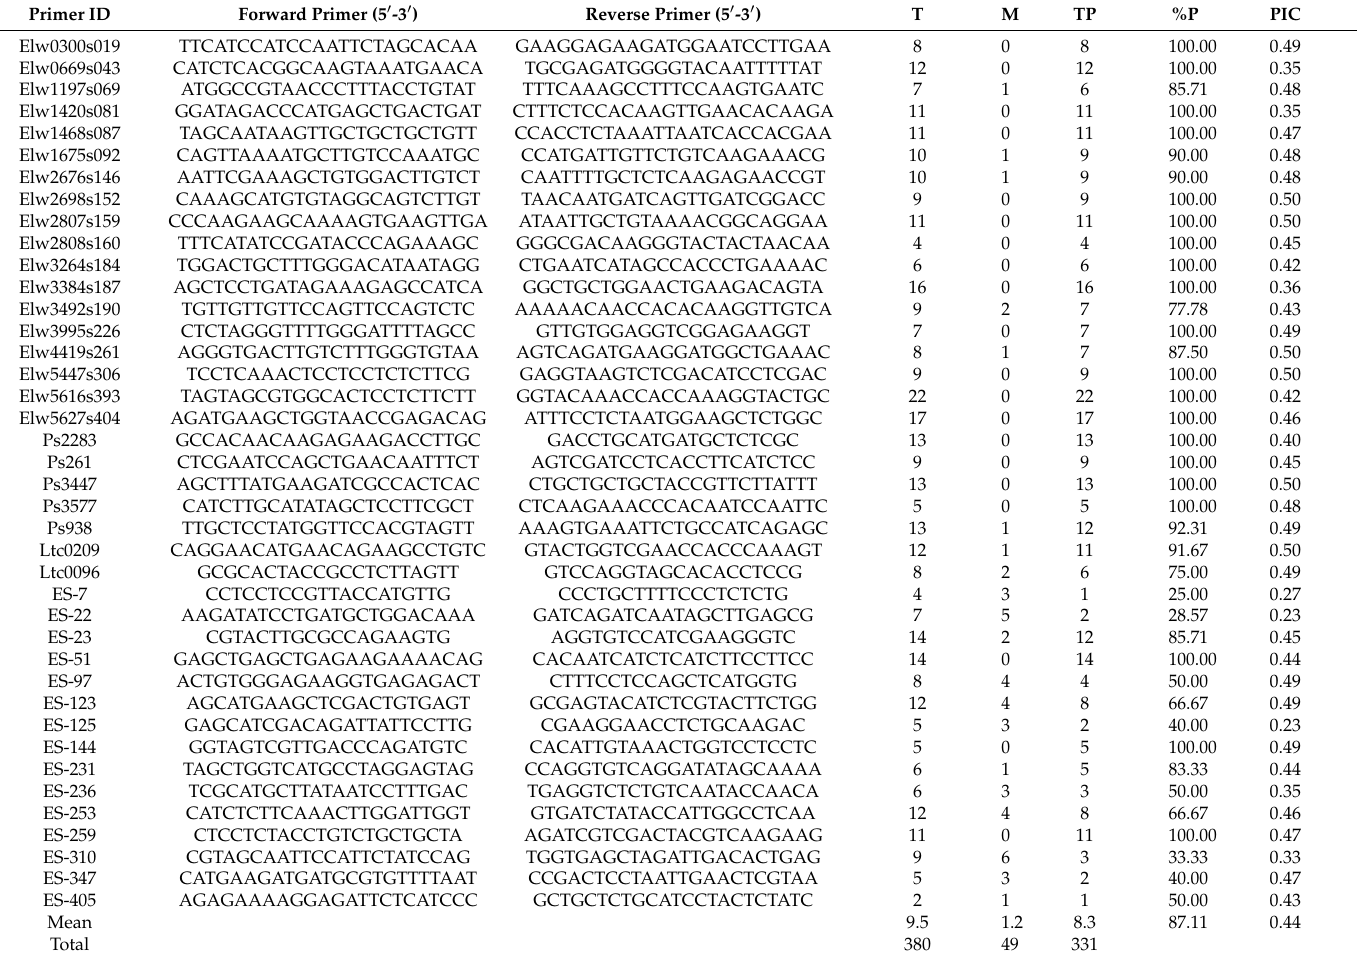
Table 2. Results achieved by Elymus (Elw), Pseudoroegneria (Ps), Leymus (Lt) and E. sibiricus (ES) EST-SSR markers, all detected in 36 E. sibiricus